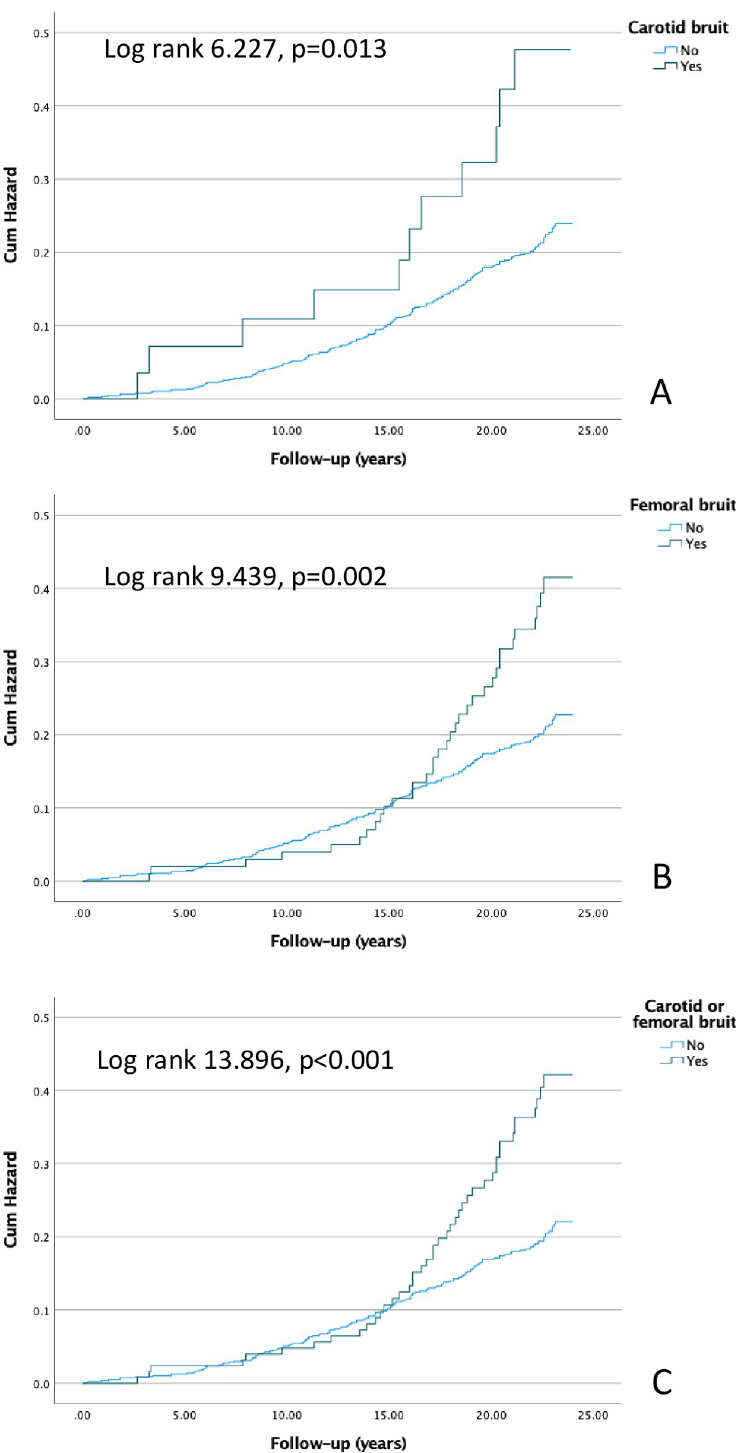
Fig 3. Kaplan-Meier curves presenting the cumulative hazards for all-cause mortality in patients with carotid bruit (A), femoral bruit (B), and carotid or femoral bruit (C).